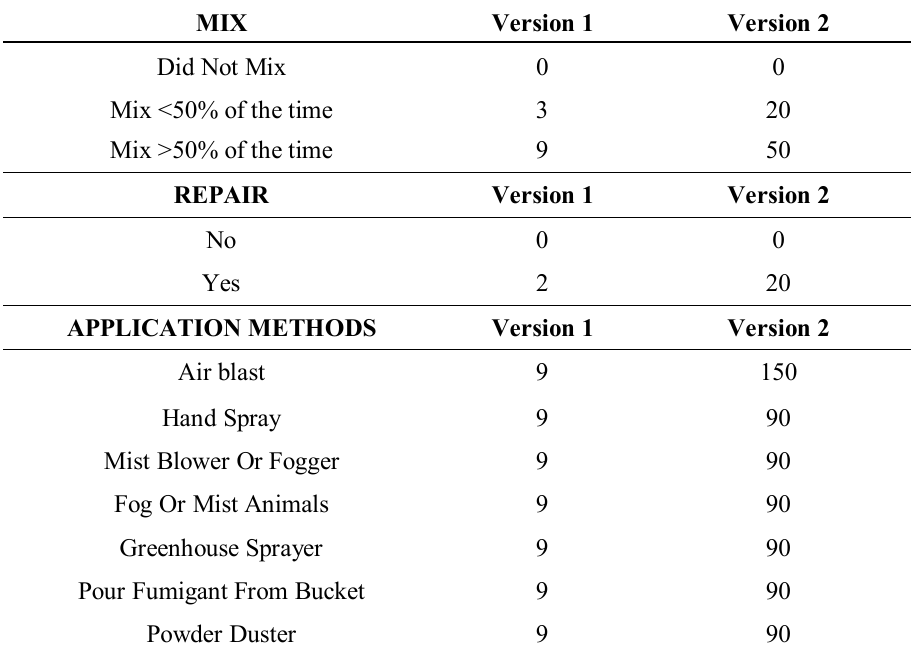
Table 2. AHS Pesticide Exposure Algorithm Weighting Factors. Algorithm Intensity Score = (MIX + APPLY + REPAIR) ×